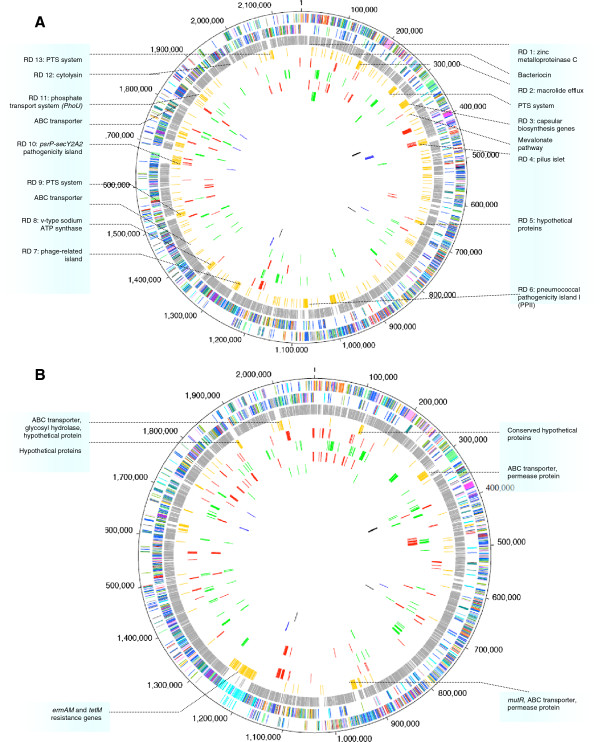
Circular representation of the S. pneumoniae TIGR4 (A) and G54 (B) genomes and transcriptomes. The two outermost circles show the predicted coding regions on the plus (outermost) and minus (2nd circle) strands color-coded by functional categories as in Tettelin et al.[60]. The third circle (light grey) shows genes that are shared by both TIGR4 and G54 genomes and the fourth circle (gold) shows strain-specific genes. Colored boxes depict genes in regions of diversity [61] as well as other strain-specific clusters (listed in Additional file 6). The red and green circles correspond to transcriptome results; fifth – genes up-regulated in adherent bacteria; sixth – genes down-regulated in adherent bacteria; seventh – genes up-regulated in non-adherent bacteria; eighth – genes down-regulated in non-adherent bacteria. The two innermost circles correspond to the genes selected for mutagenesis (asterisked loci in Table 1); blue – successfully knocked out (SP_0462-SP_0468, SP_0737, SP_1294-SP_1295, SP_1758, SP_1855 and SP_1922) and black – unsuccessful/not viable (SP_0423-SP_0427, SP_0783 and SP_1270).